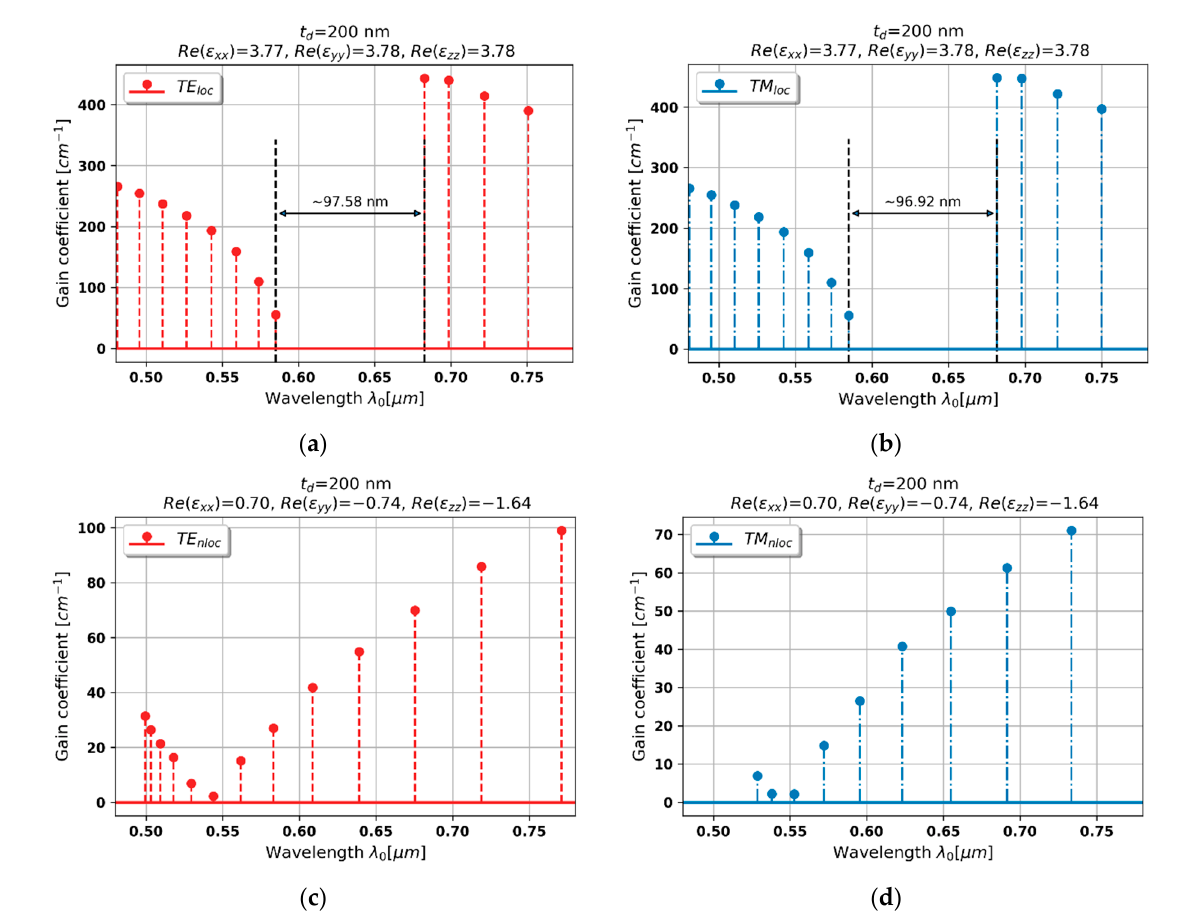
Figure 8. Modal spectra for TE ( a , c ) and TM-polarized light ( b , d ) for a PHC laser based on hyper- bolic medium with 𝑡 (cid:3027)(cid:3041)(cid:3016) = 200 nm dielectric layer (black double-headed arrow denotes spectral medium with t ZnO = 200 nm dielectric layer (black double-headed arrow denotes spectral width of width of stop band of the spectrum). stop band of the